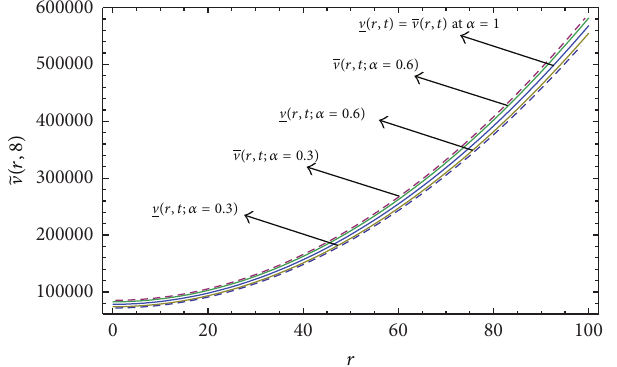
Figure 15: Interval solution of Case 5 at 𝑡 = 8